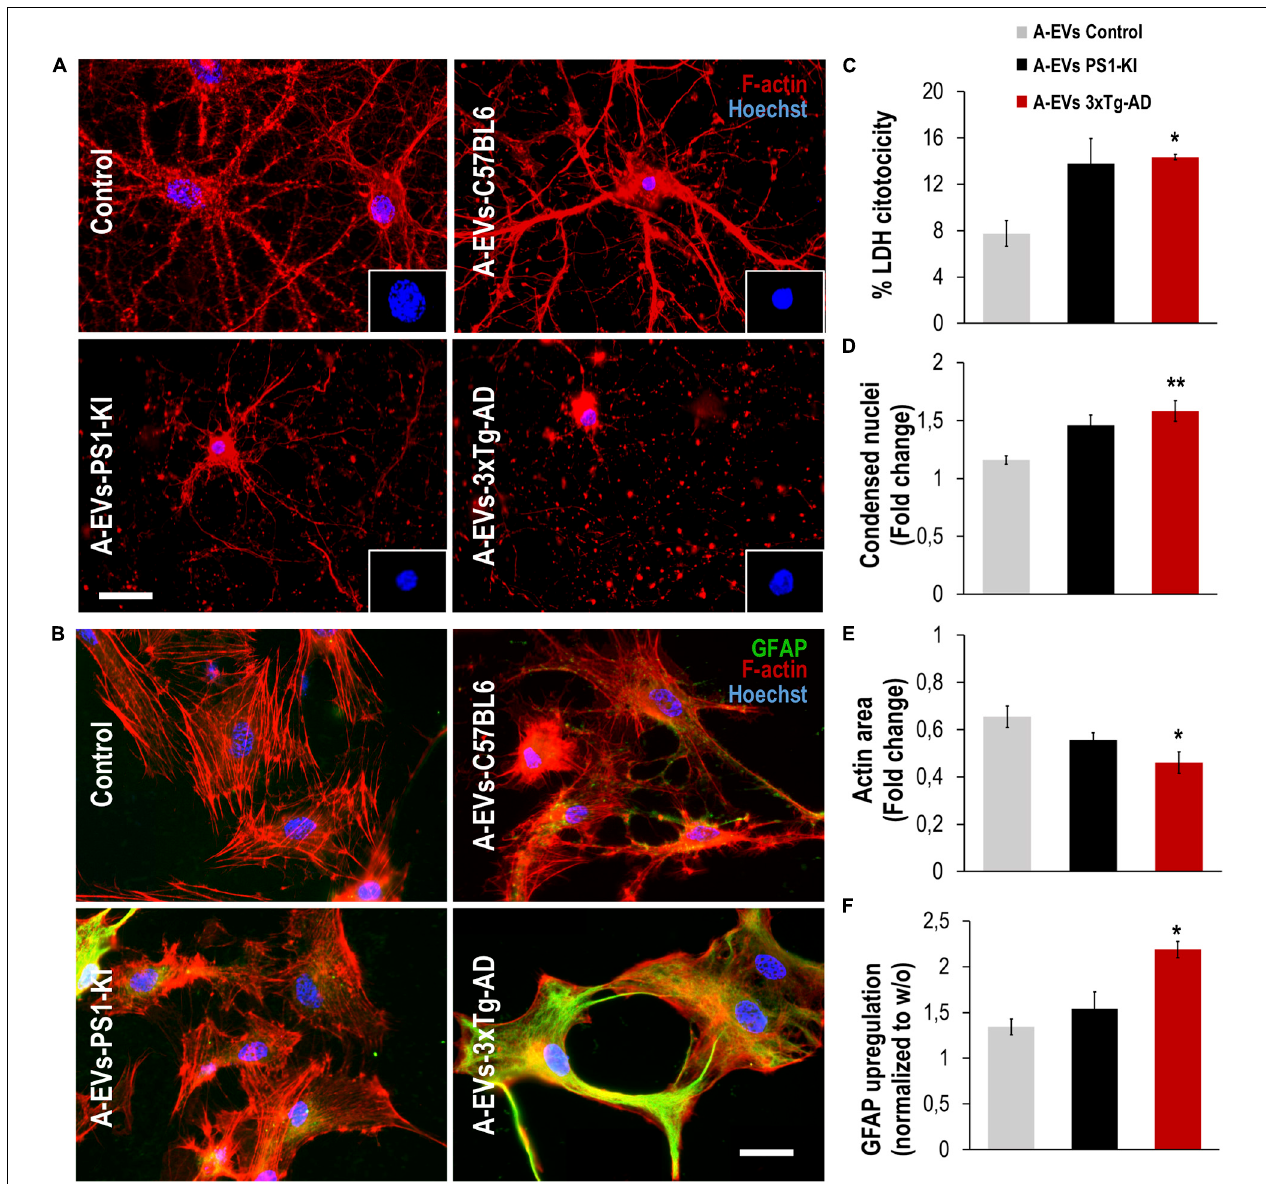
FIGURE 4 | 3xTg-AD A-EVs induce astrocyte-neuronal damage. (A) Morphological characterization showing neurons: F-actin in red and nuclei were stained with Hoechst (blue). Magnification × 60, scale bar 20 µ m. (B) The cytotoxicity of co-culture astrocytes-neurons is expressed as the percentage of LDH released from cells 24 h after C57BL6-, PS1-KI and 3xTg-AD A-EVs. (C,D) Fold change data calculated by dividing the values by the value obtained from cells with no A-EVs treatment. (C) fold change of the percentages of F-actin per field of neurons and (D) fold change of the percentage of condensed nuclei of neurons treated with C57BL6-, PS1-KI and 3xTg-AD A-EVs. (E) Morphological characterization showing astrocytes: F-actin in red, GFAP in green and nuclei in blue. Magnification × 60, calibration bar 20 µ m. (F) Fold change data calculated by dividing the values by the value obtained from cells with no EV treatment, Fold change of GFAP intensity (MFI) of astrocyte. Representative data from n = 3. Data were plotted as means and SEM. Kruskal–Wallis test and Dunn’s multiple comparison test. ∗ Indicates p < 0.05; ∗∗ indicates p < 0.01.